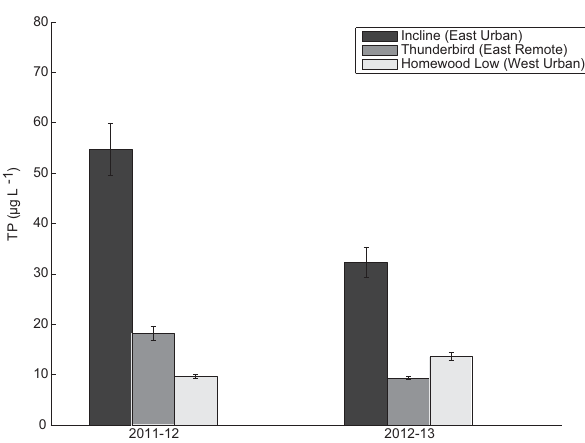
Figure 8. Average snowpack total phosphorus concentrations at all lake-level sites. The Incline and Thunderbird sites are located on the east side of the basin in urban and remote settings, respectively, and the Homewood Low site is located on the west side of the basin in an urban